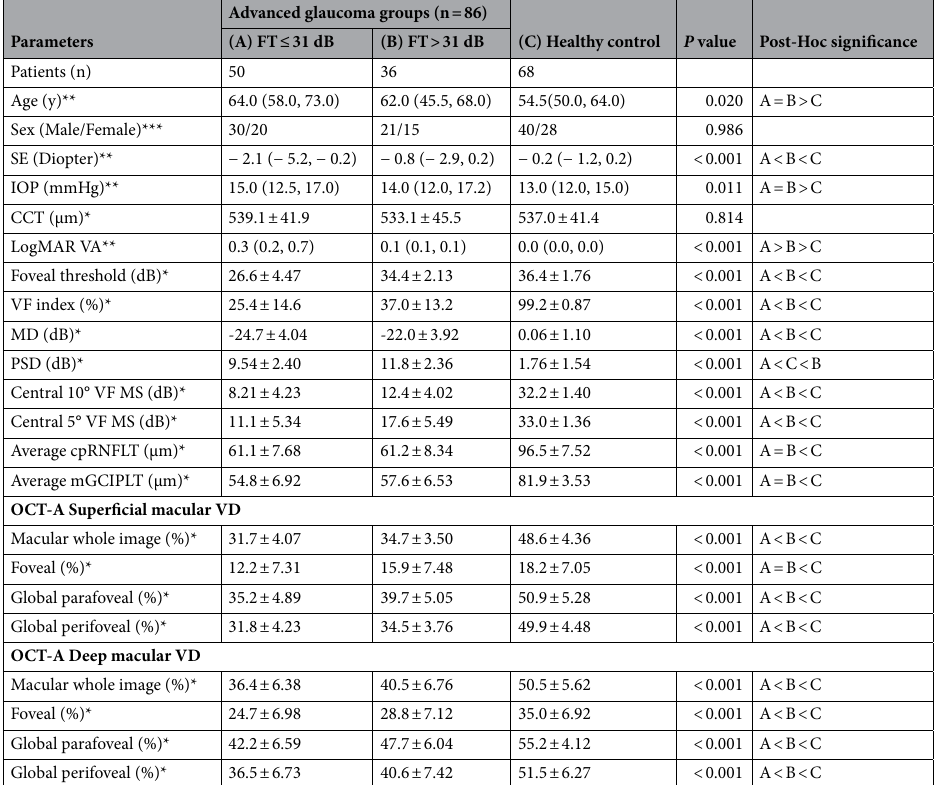
Table 1. Comparison of demographic and clinical characteristics between the advanced glaucoma patients and healthy controls. Data with normal distribution were shown as mean ± standard deviation, otherwise data with non-normal distribution were shown as median (25th, 75th percentile). FT, foveal threshold; n, number; SE, spherical equivalent; IOP, intraocular pressure; CCT, central corneal thickness; VA, visual acuity; VF, visual field; MD, mean deviation; PSD, pattern standard deviation; MS, mean sensitivity; cpRNFLT, circumpapillary retinal nerve fiber layer thickness; mGCIPLT, macular ganglion cell-inner plexiform layer thickness; OCT- A, optical coherence tomography angiography; VD, vessel density. *One-way ANOVA was used for normally distributed data with Bonferroni post-hoc test for multiple comparisons, **Kruskal–Wallis analysis was used for non-normally distributed data with Dunnett post-hoc test for multiple comparisons, ***Pearson’s chi- square test was used for categorial